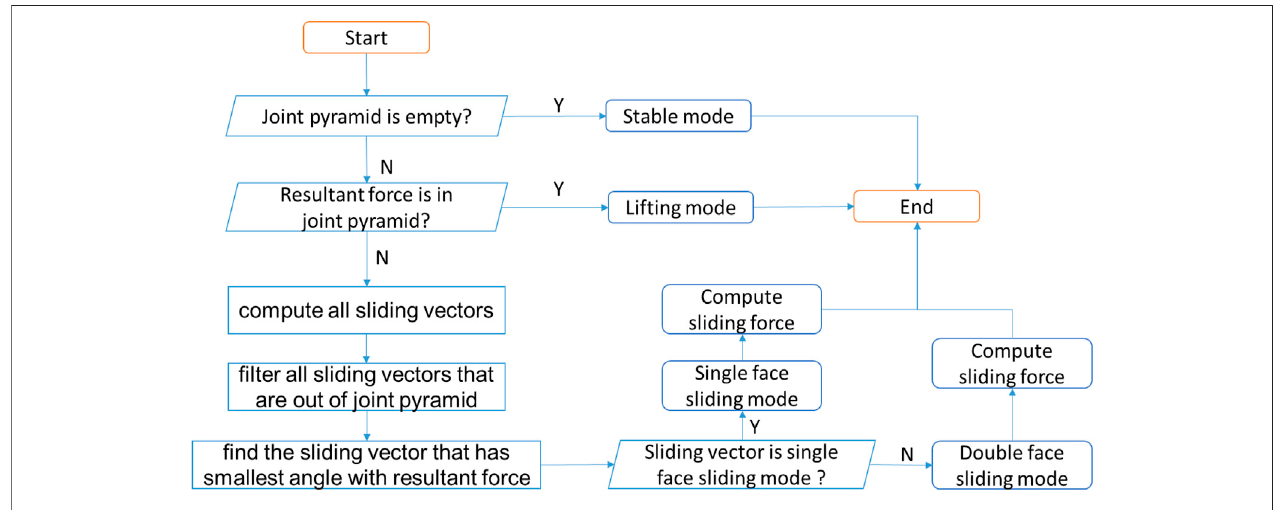
FIGURE 4 | Judgement of the stability of a block.